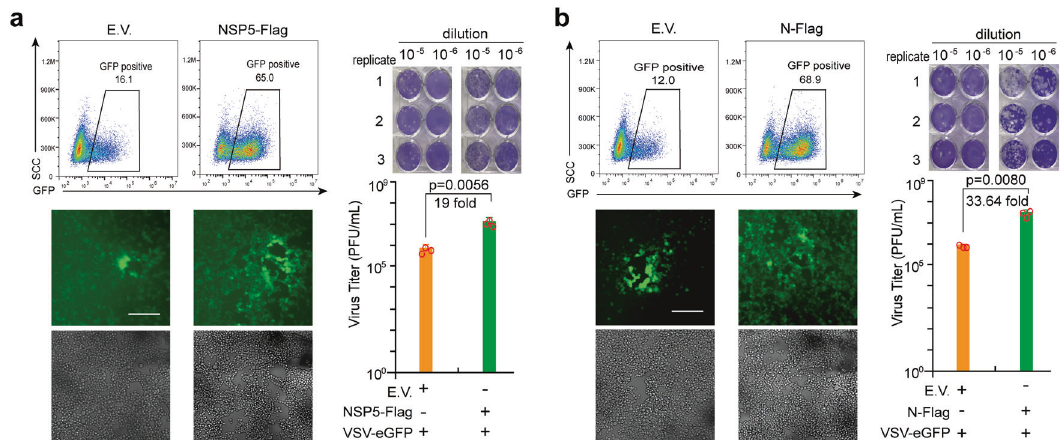
Fig. 2 SARS-CoV-2 NSP5 and N facilitate viral replication. The HEK293T cells were subjected to transfection with empty vector (E.V.), NSP5 ( a )-, or N ( b )-expressing plasmids as indicated for 24 h. The cells were subsequently infected with VSV-eGFP (MOI = 0.001) for 12 h before imaging and fl ow cytometry analysis. The culture supernatant collected at 20 h postinfection was used to determine viral titers (PFU per mL) via plaque assays. The fl uorescent imaging and fl ow cytometry data are representative of two independently performed experiments with similar results. Scale bar, 50 μ m. In plaque assays, data are presented as mean values ± SEM from triplicate infections from one representative experiment of two. Statistical signi fi cance is shown as indicated. EV empty vector, h hours, PFU plaque-forming